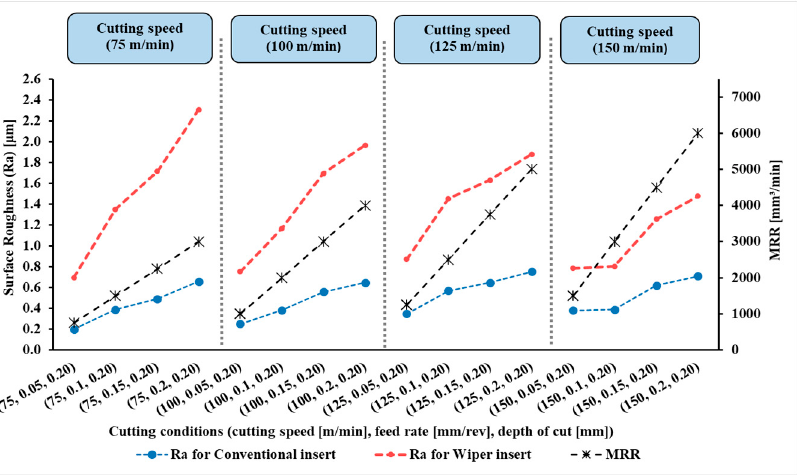
Figure 6. Surface roughness (Ra) and material removal rate (MRR) for AISI 4340 workpieces machined by wiper and conventional inserts at depth of cut ( a p ) of 0.20 mm and variant cutting speeds and feed rates (reproduced results originally reported in [6]).